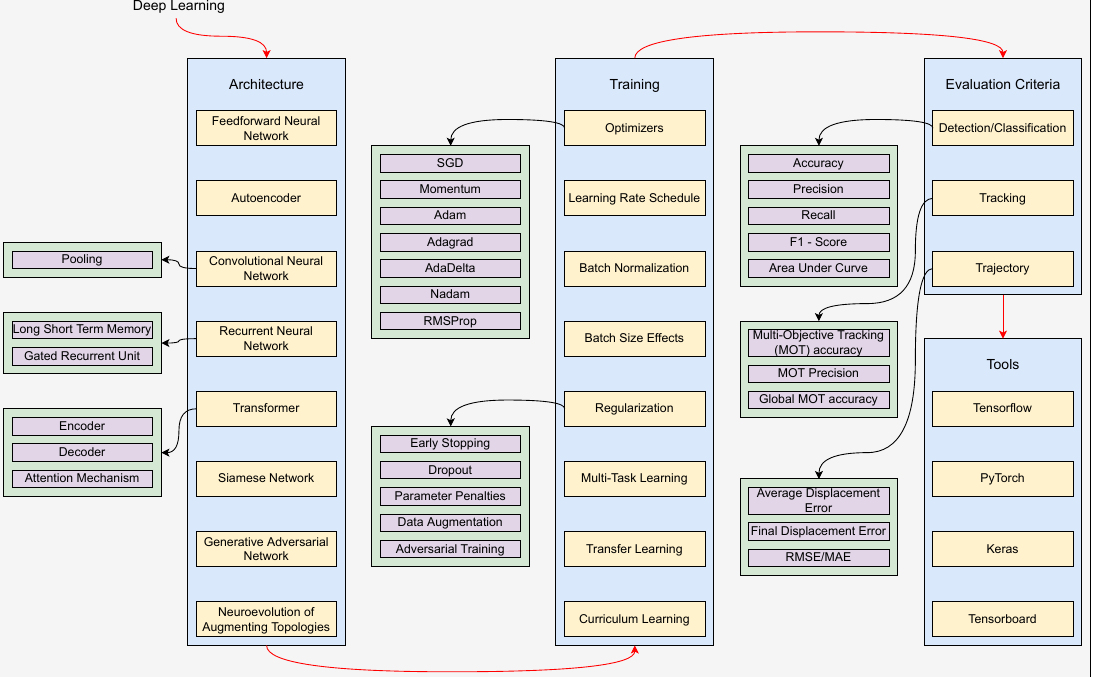
Figure 8. Block diagram of the road map to machine learning architecture selection and training.